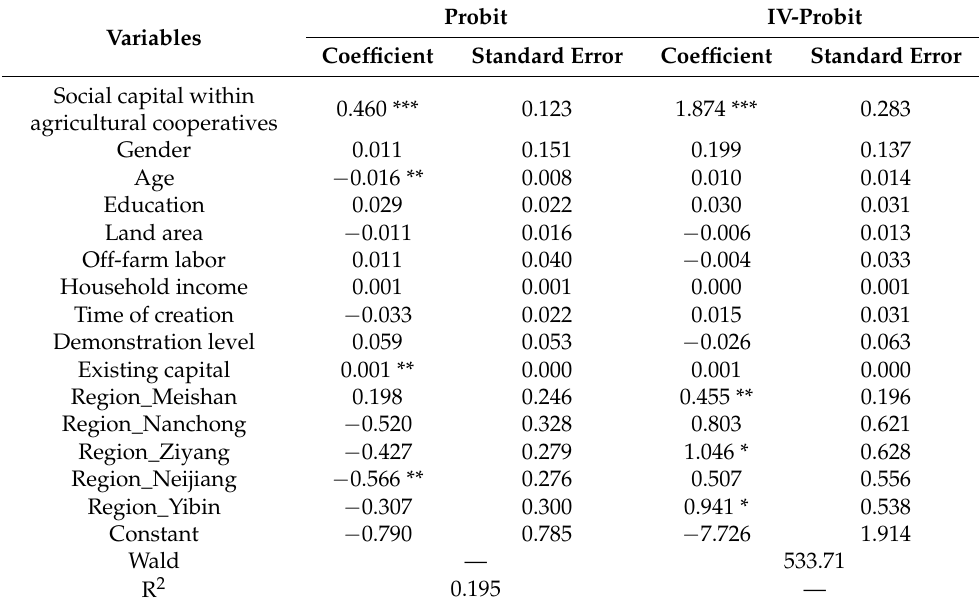
Table 3. The estimation results of Probit model and IV-probit